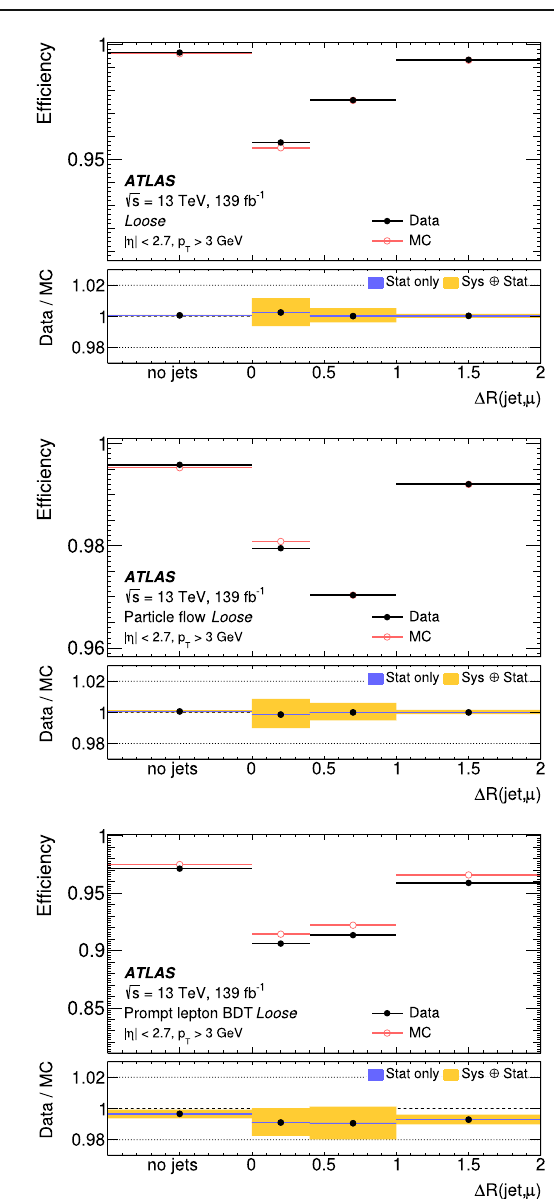
in Sect. 6.2.4. Reflecting the plots on the right of Figs.